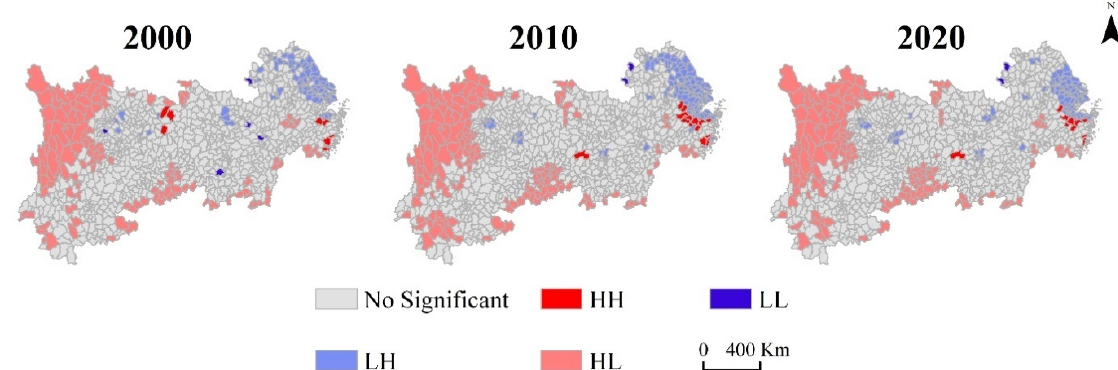
Figure 7. Scatter plot of Moran’s I index between the CESDR and the CUL in the YREB from 2000 to 2020.